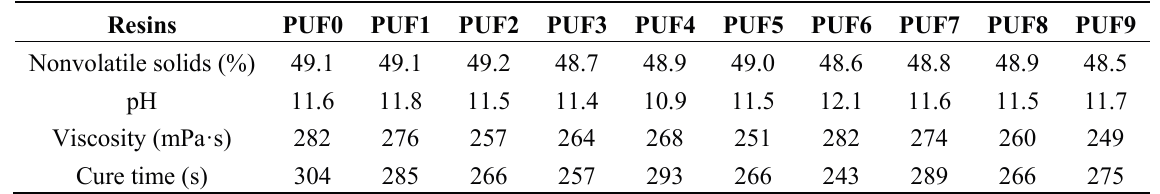
Table 1. Properties of the control and MgO-catalyzed phenol-urea-formaldehyde (PUF)